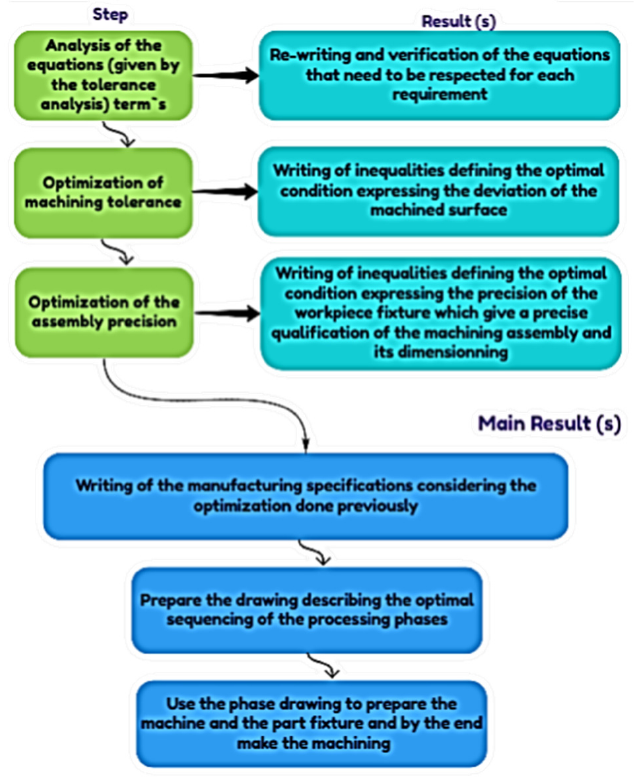
Figure 2. Synthesis phase flowchart.